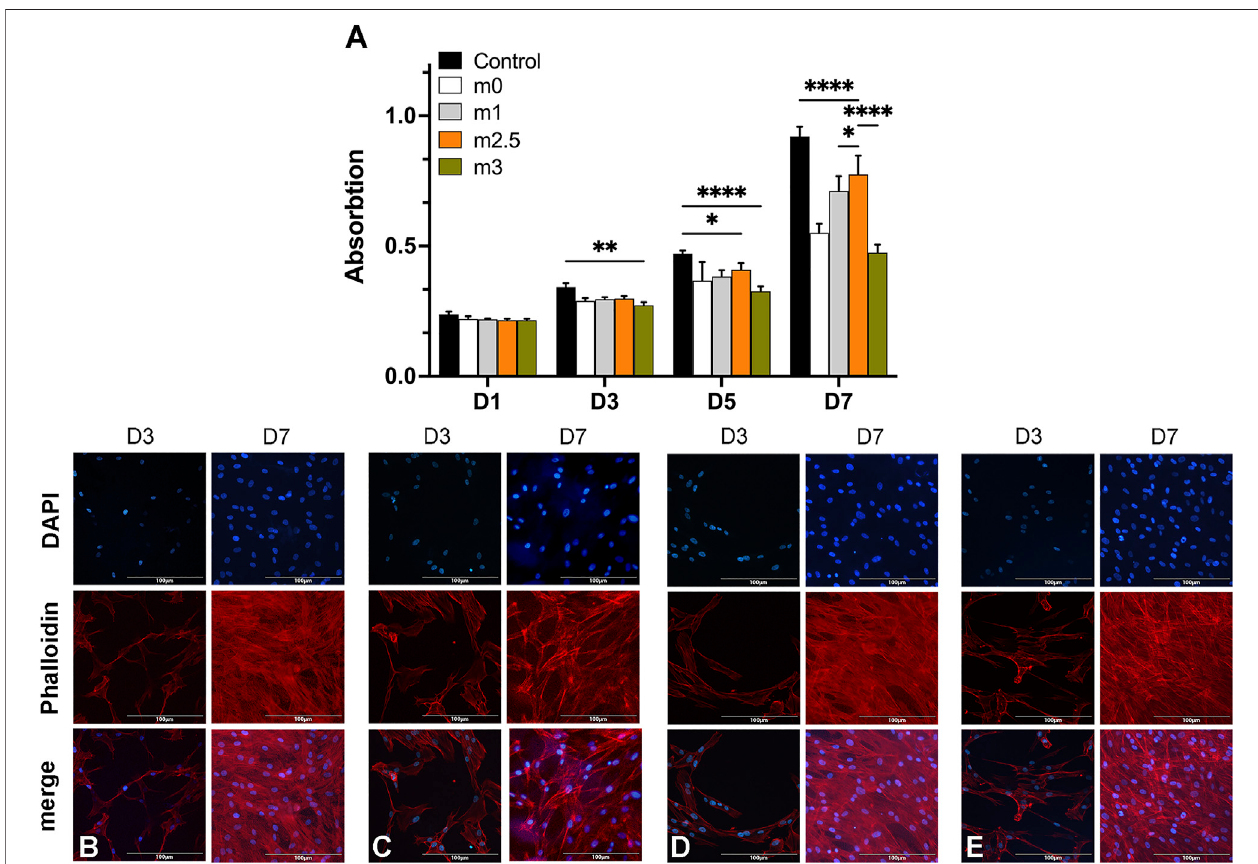
FIGURE3|(A) CCK8assayofBMSCson2Dhydrogel fi lmsatdifferenttimeintervals(Day1,3,5,and7). (B – E) cellson fi lmsstainedwithDAPI(blue)andphalloidin (red) on day 3 and day